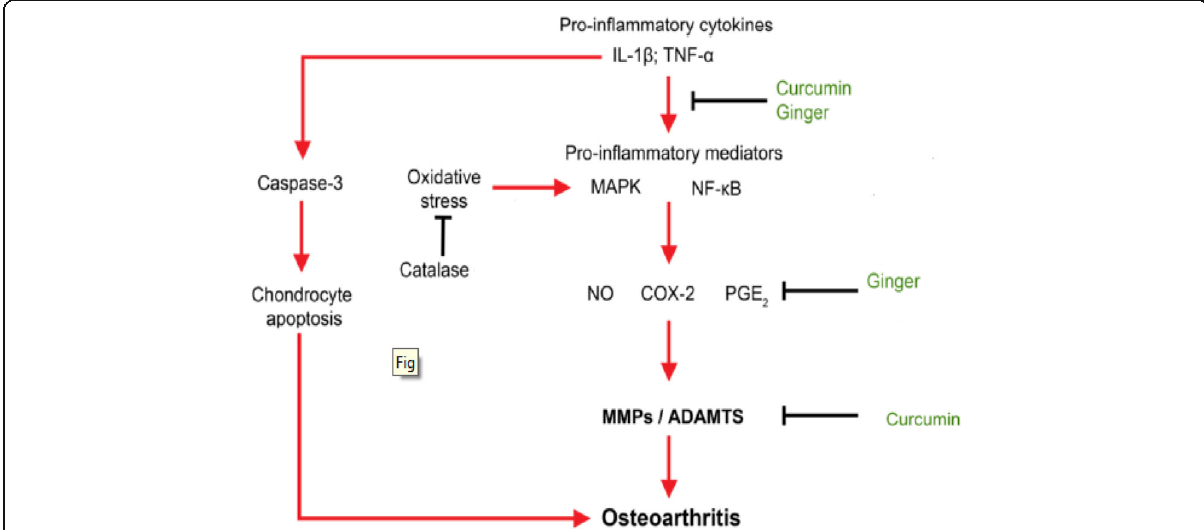
Fig. 7 A schematic representation of possible mechanisms by which ginger and curcuma extracts can regulate inflammation level in osteoarthritis. Adapted from Leong et al., 2013